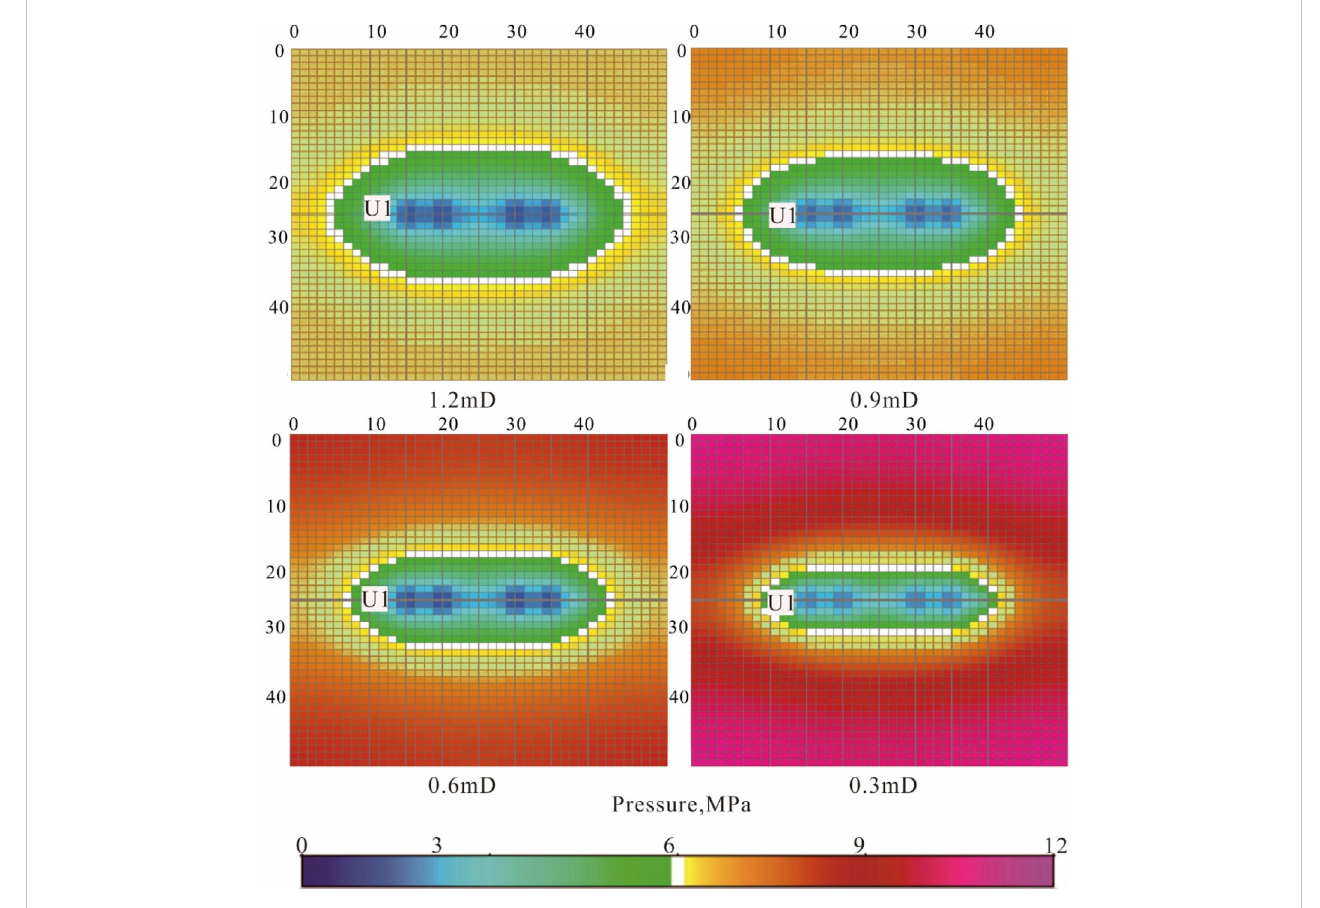
FIGURE 4 Plane distribution of coal seam pressure drop effect under different permeability conditions.